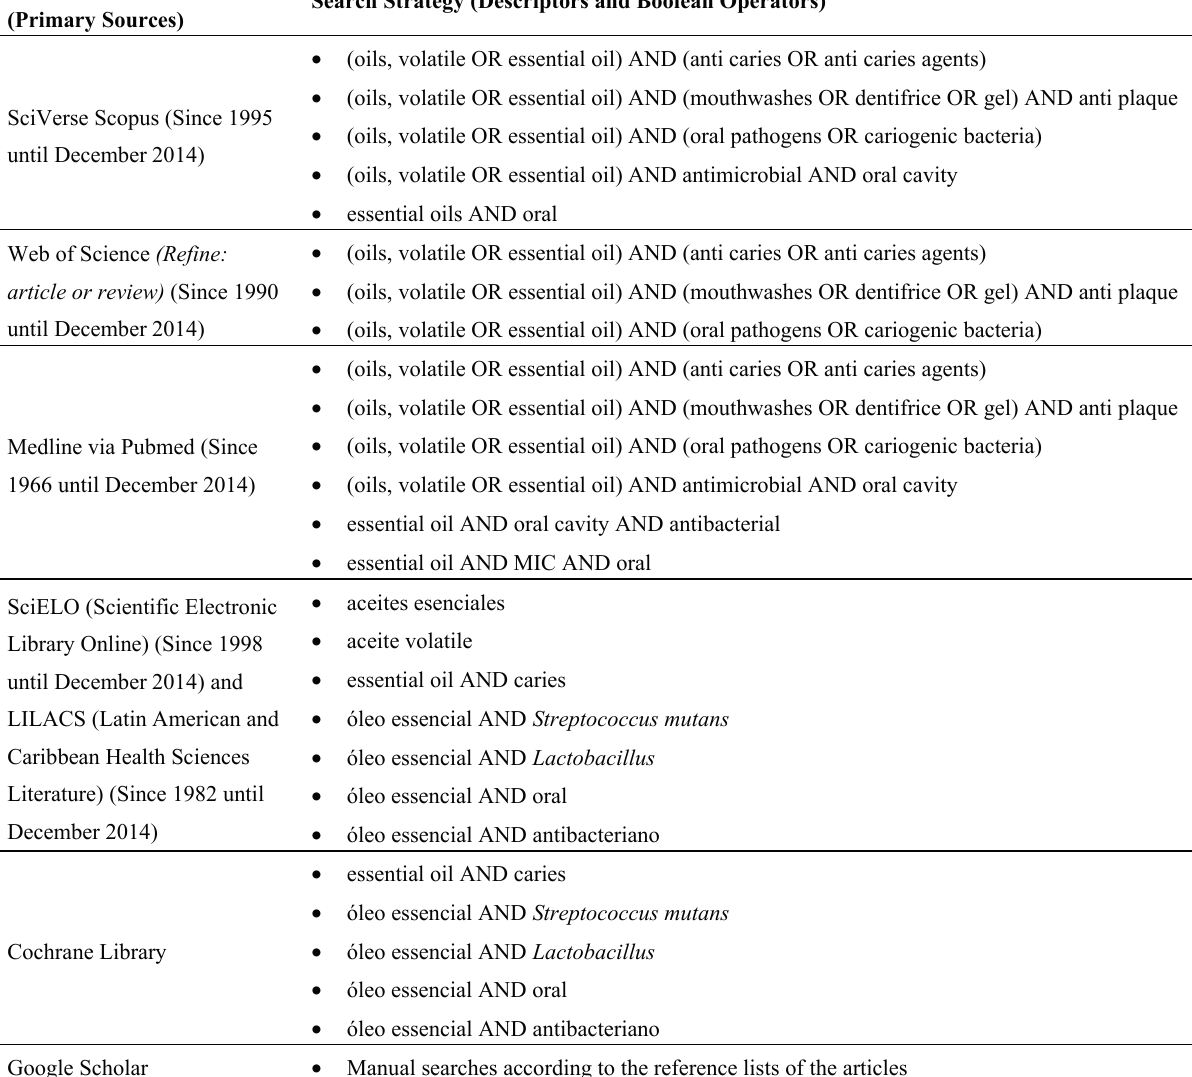
Table 10. Search strategy and bibliographic databases used to retrieve the articles falling into the scope of this systematic